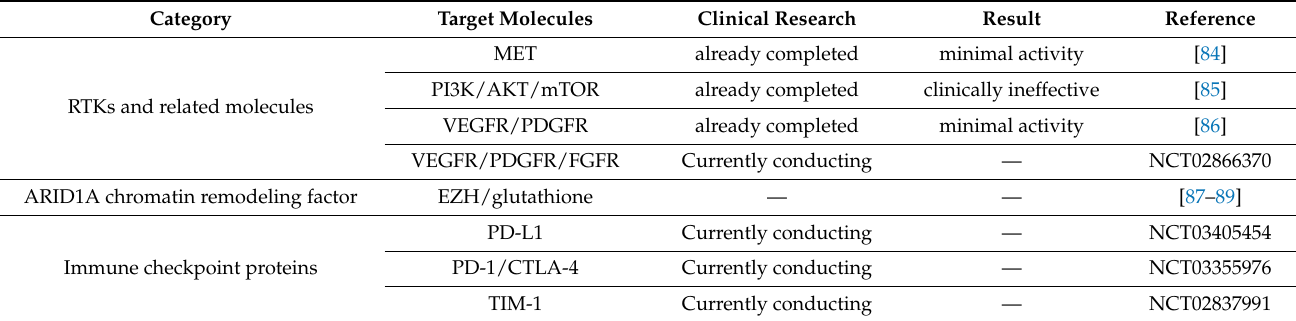
Table 3. Molecular targeting drugs and the clinical trials to treat OCCCs (ovarian clear cell carcinomas).